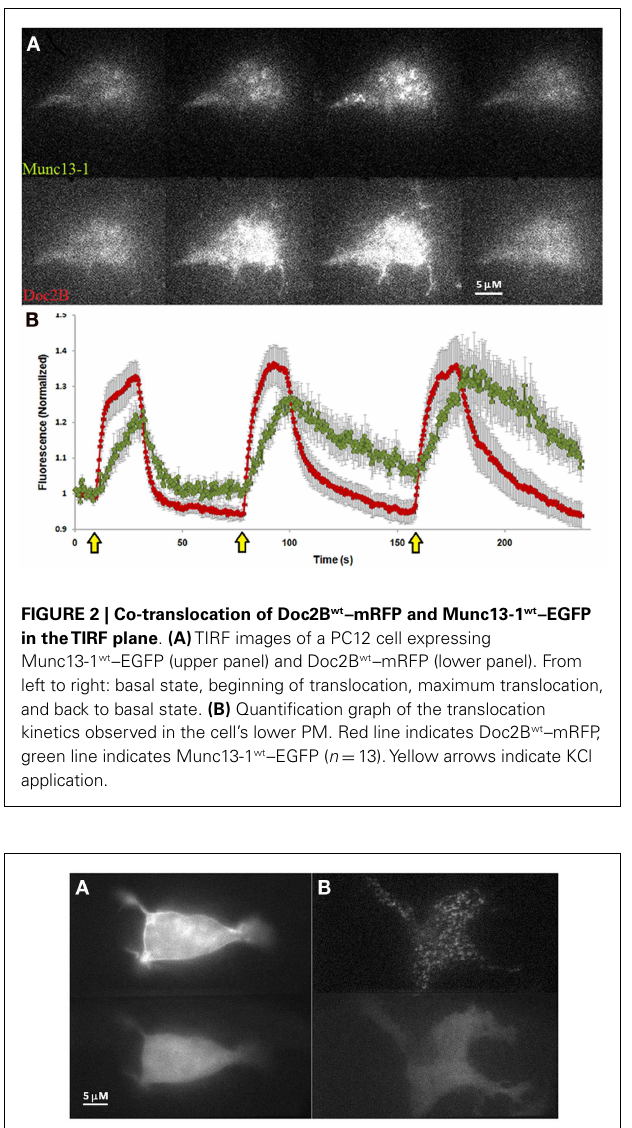
FIGURE 3 | PE stimulation of PC12 cell co-expressing Doc2B wt –mRFP and Munc13-1 wt –EGFP . (A) Epi-fluorescence images of a PC12 cell co-expressing Munc13-1 wt –EGFP (upper panel) and Doc2B wt –mRFP (lower panel) after PE application. Munc13-1 wt translocated to the PM while Doc2B wt did not. (B) TIRF images of a PC12 cell co-expressing Munc13-1 wt –EGFP (upper panel) and Doc2B wt –mRFP (lower panel) after PE application. Munc13-1 wt translocated to the PM while Doc2B wt did not. Note the patchy nature of Munc13-1 wt ’s translocation at the